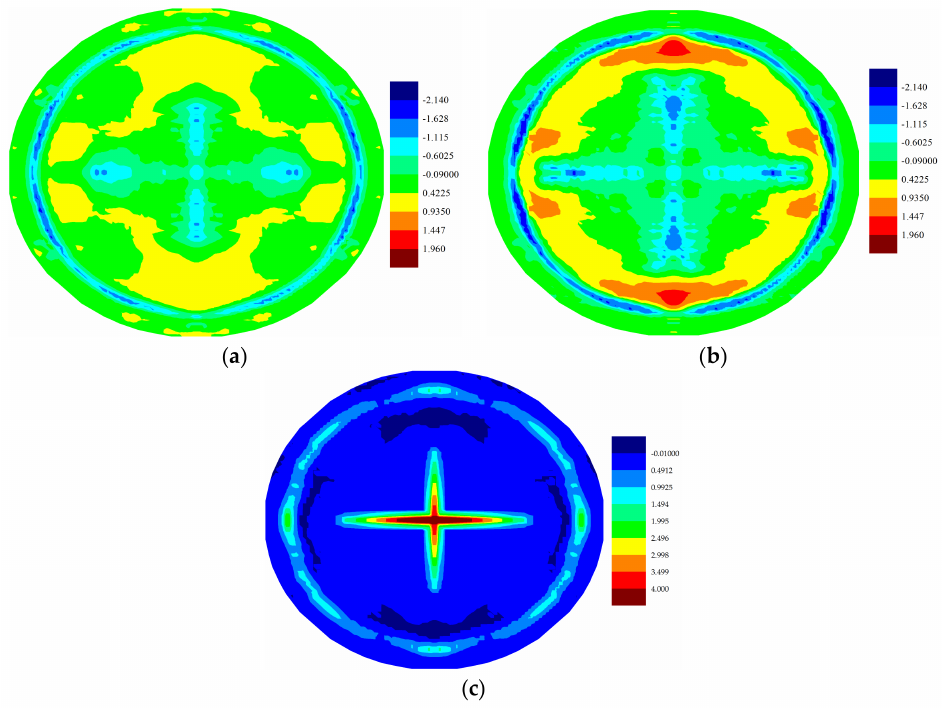
Figure 21. ( a ) Distribution of temperature change (K) of top ply at 0.28453 × 10 − 3 s; ( b ) Distribution of temperature change (K) of top ply at 0.3461 × 10 − 3 s; ( c ) Maximum stretch distribution of top ply at 0.3461 × 10 − 3 s.